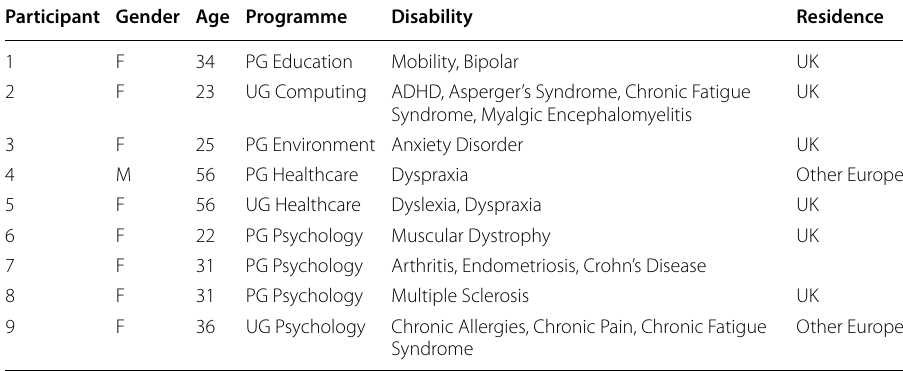
PG postgraduate, UG